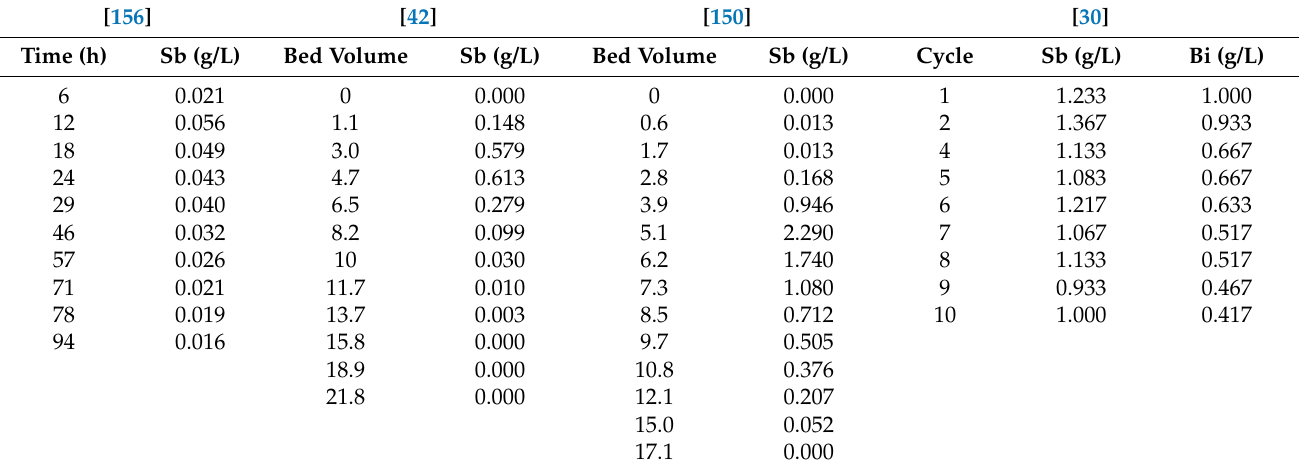
Table 14. Concentration of Sb and Bi (in g/L) in HCl elution solutions leaving ion-exchange